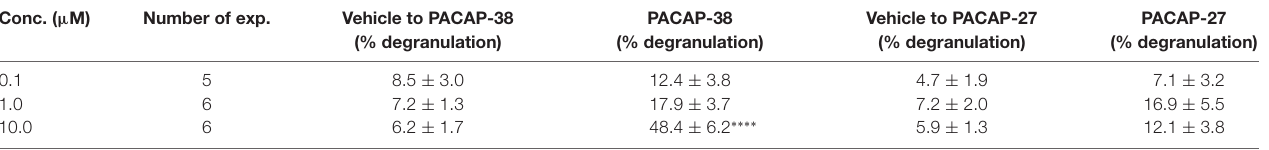
TABLE 2 | The number of degranulated meningeal mast cells in % of total number of mast cells after 30 s incubation with either vehicle, PACAP-38 or PACAP-27 in concentrations ranging from 0.1 to 10 µ M. Conc. ( µ M) Number of